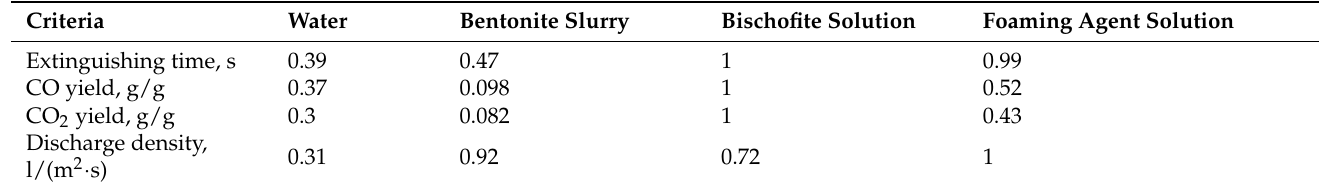
Table 9. Normalized criteria for fire extinguishing agent efficiency evaluation.